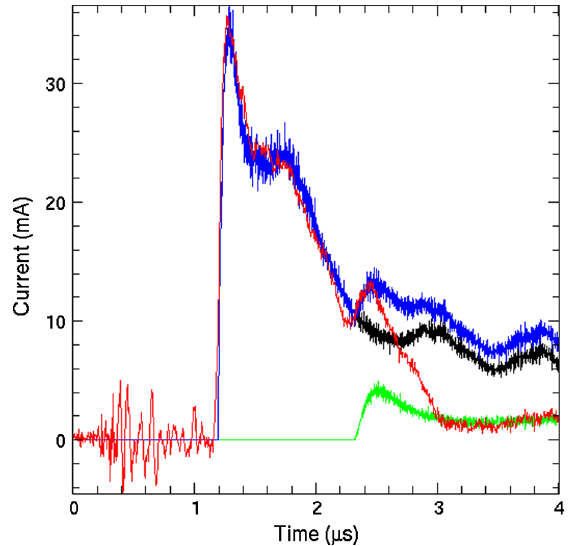
FIG. 5. Beam current measured in the Faraday cup for various injector voltages. The plotted voltage waveform is for a peak source voltage of 118 kV. The HV waveforms scale linearly with amplitude.